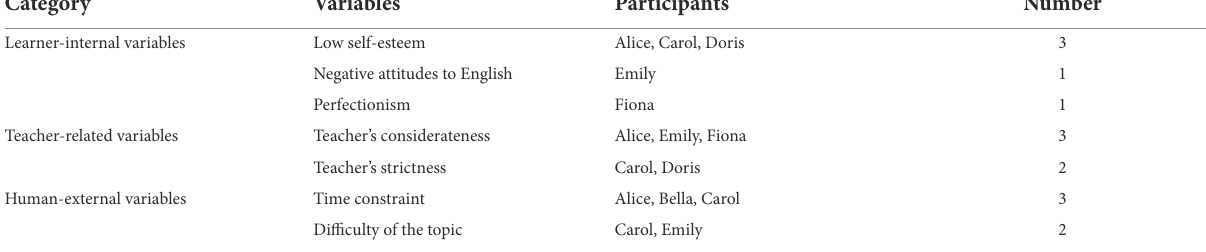
TABLE 2 Variables related to